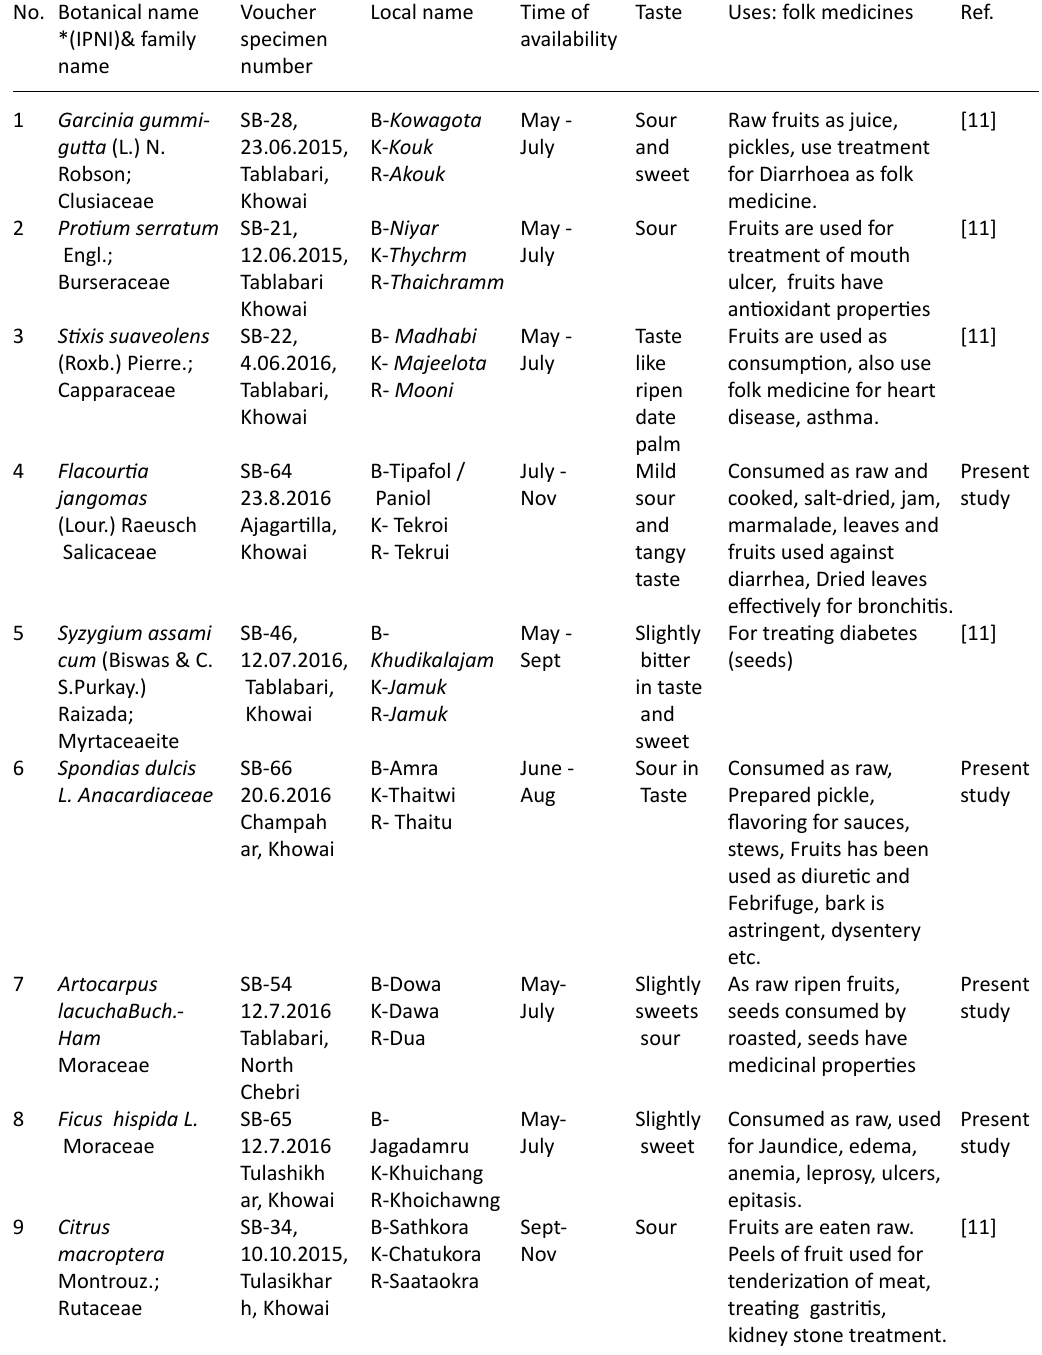
table 1. List of wild edible minor fruits of Tripura, India considered for the study No. Botanical